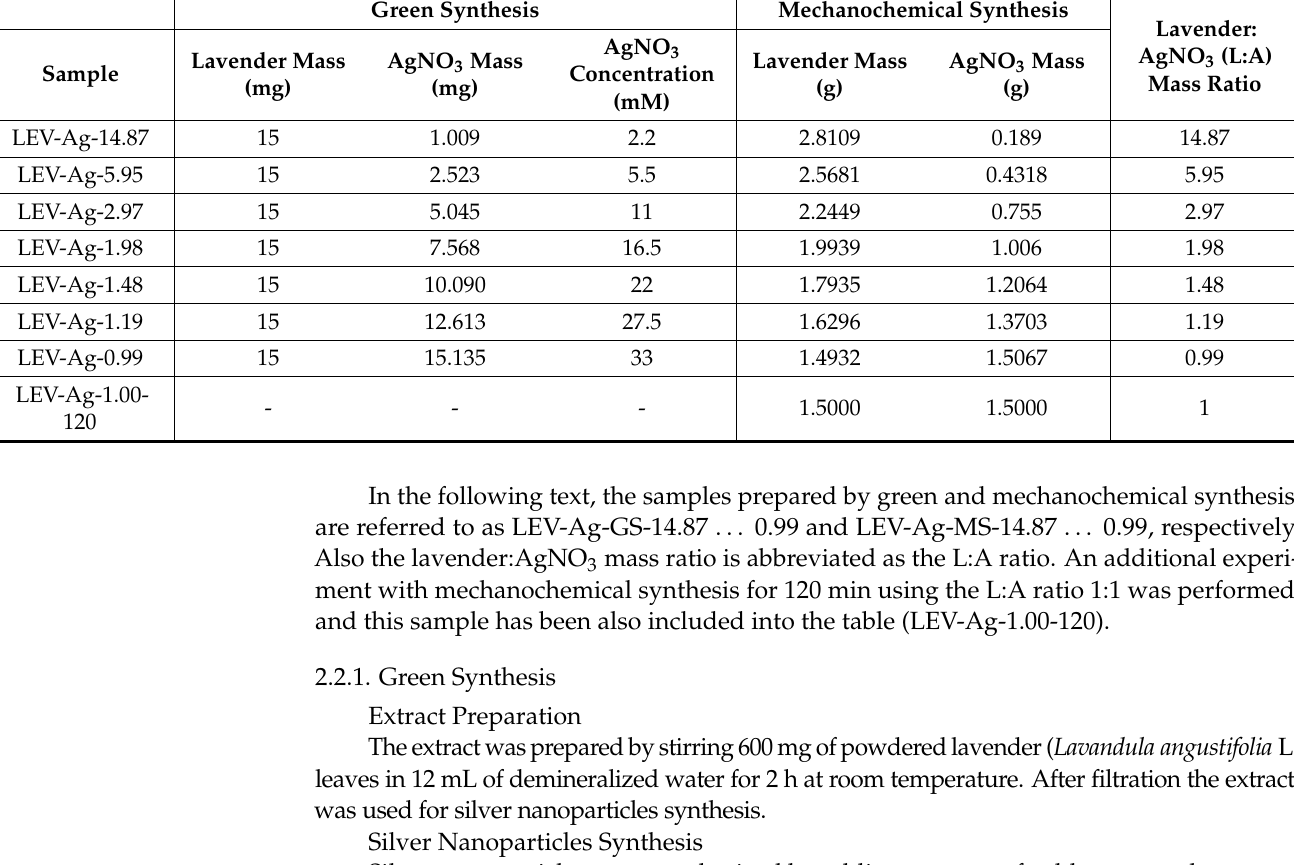
Table 1. Masses of lavender and AgNO 3 in both green (GS) and mechanochemical syntheses (MS) and corresponding lavender:AgNO 3 (L:A) mass ratios. Green Synthesis Mechanochemical Synthesis Lavender Mass